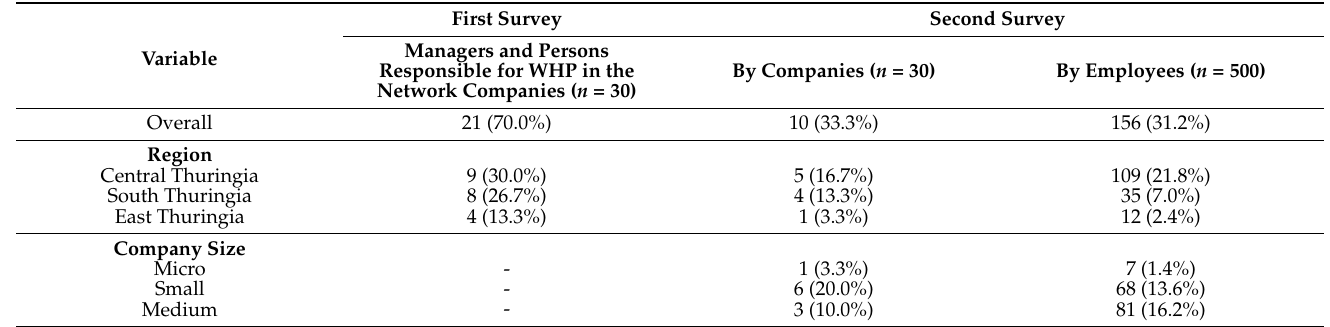
Table 2. Response